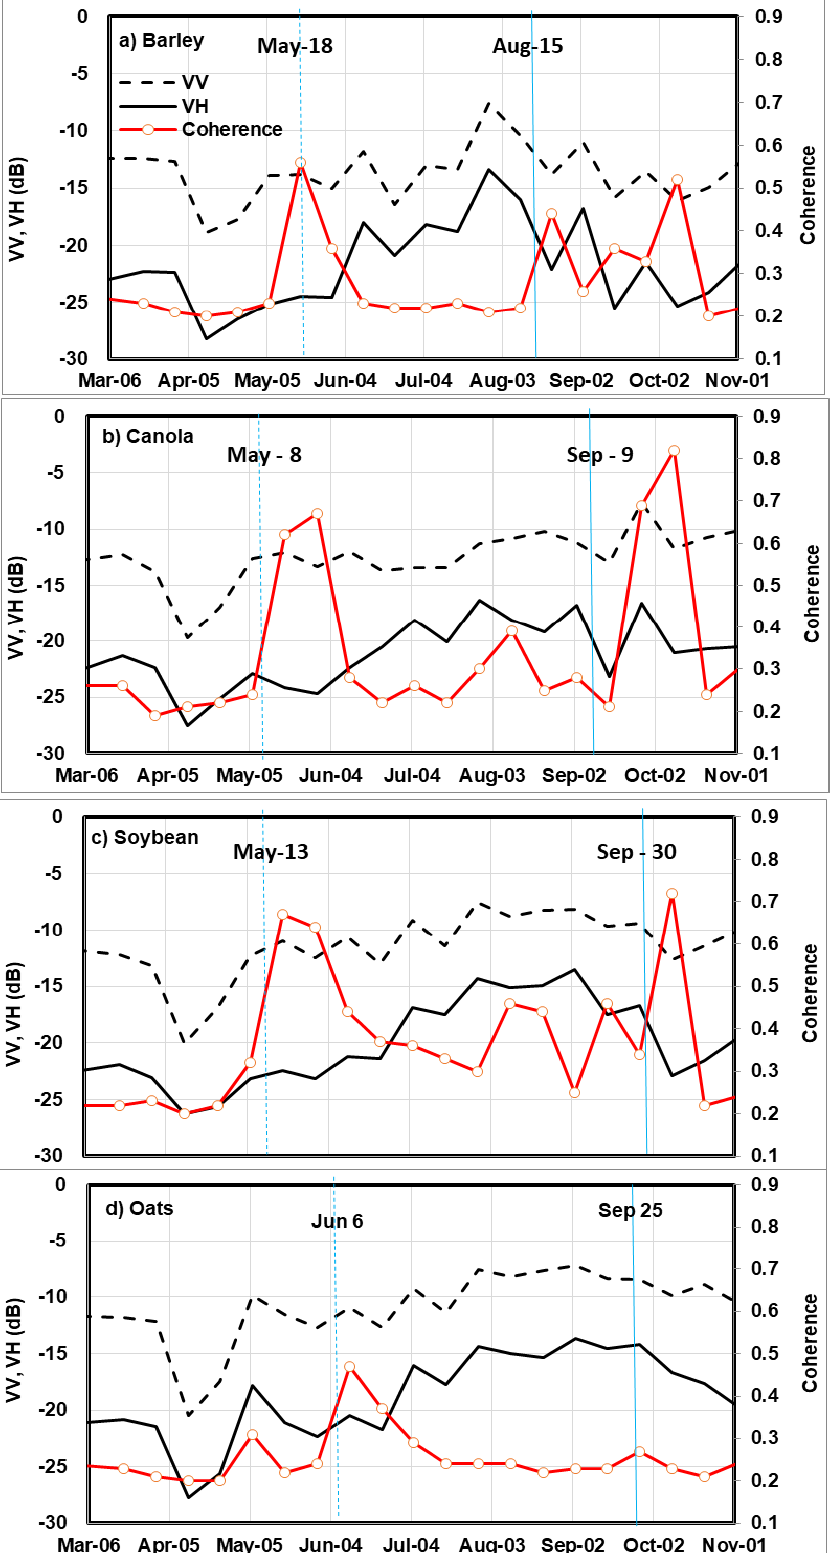
Figure 6. Time-series SAR data and seeding/harvest dates for example fields of ( a ) barley, ( b ) canola, ( c ) soybean and ( d ) oats. Vertical blue lines mark the observed seeding date (dashed) and harvest date (solid).